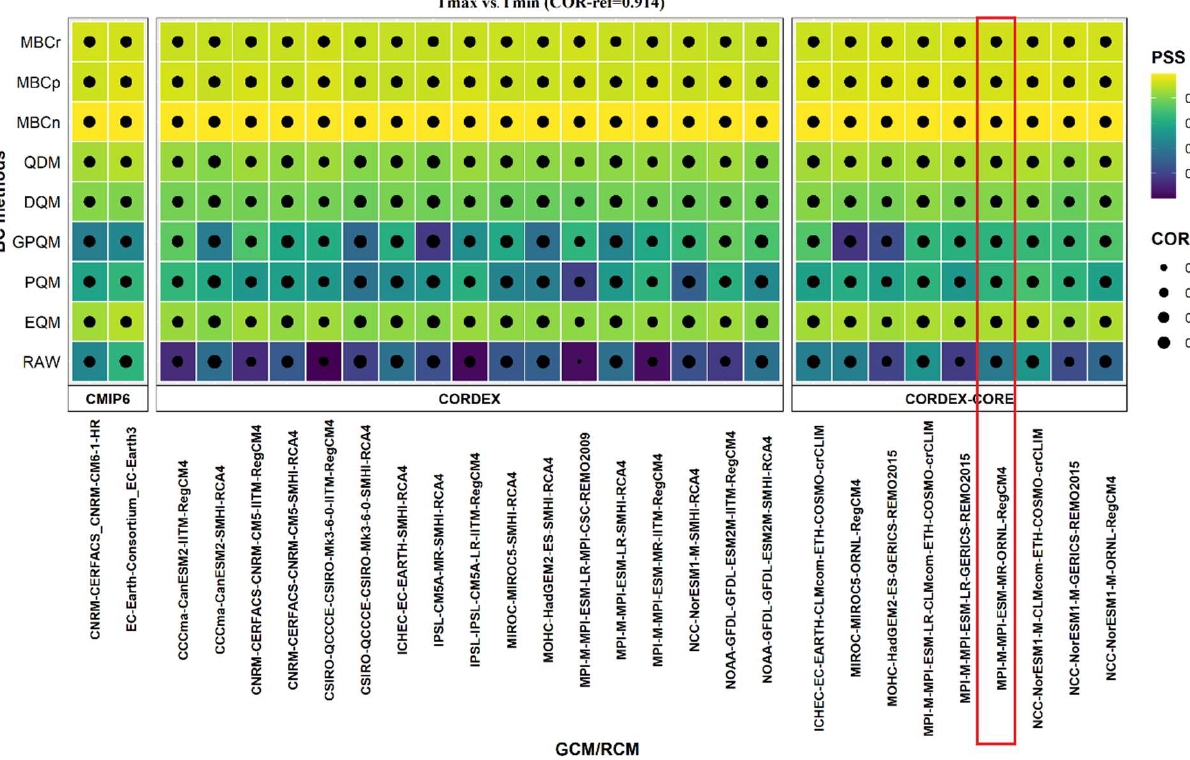
Figure 1. Pearson correlation coefficient (COR, circle) between maximum and minimum temperatures and Perkins skill score (PSS, colored scale) of the joint PDFs for the raw and bias-corrected climate model data (only component-wise approach). The correlation for the reference dataset is shown at the top of the figure. The highlighted RCM (red square) is selected for further analyses in Fig.